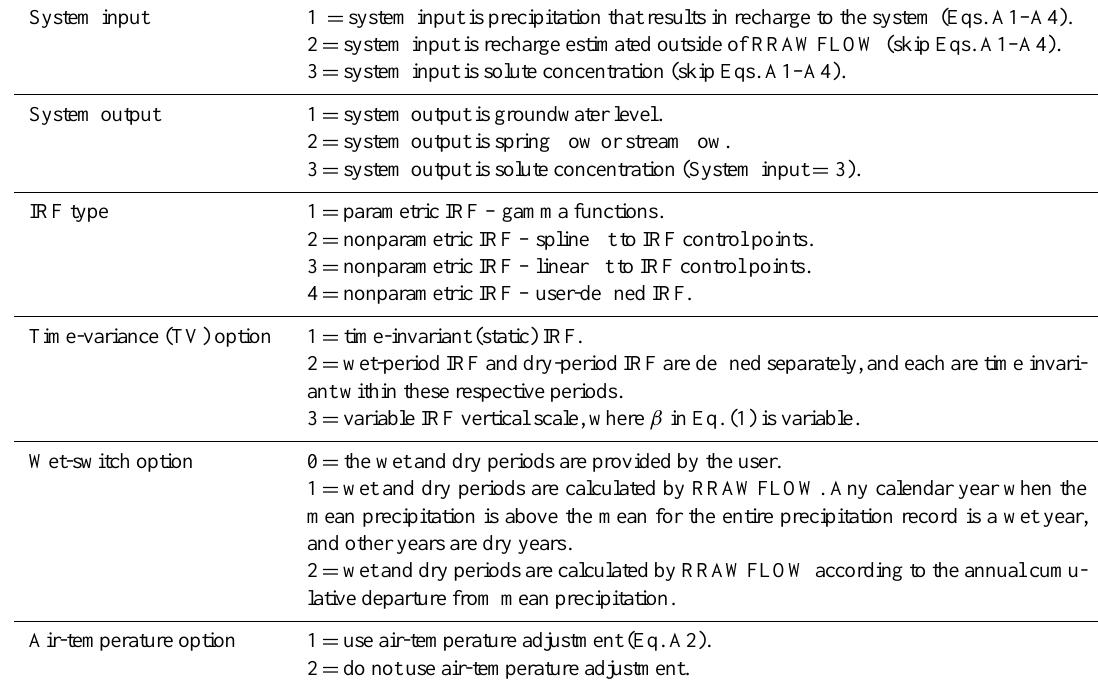
Table 1. RRAWFLOW